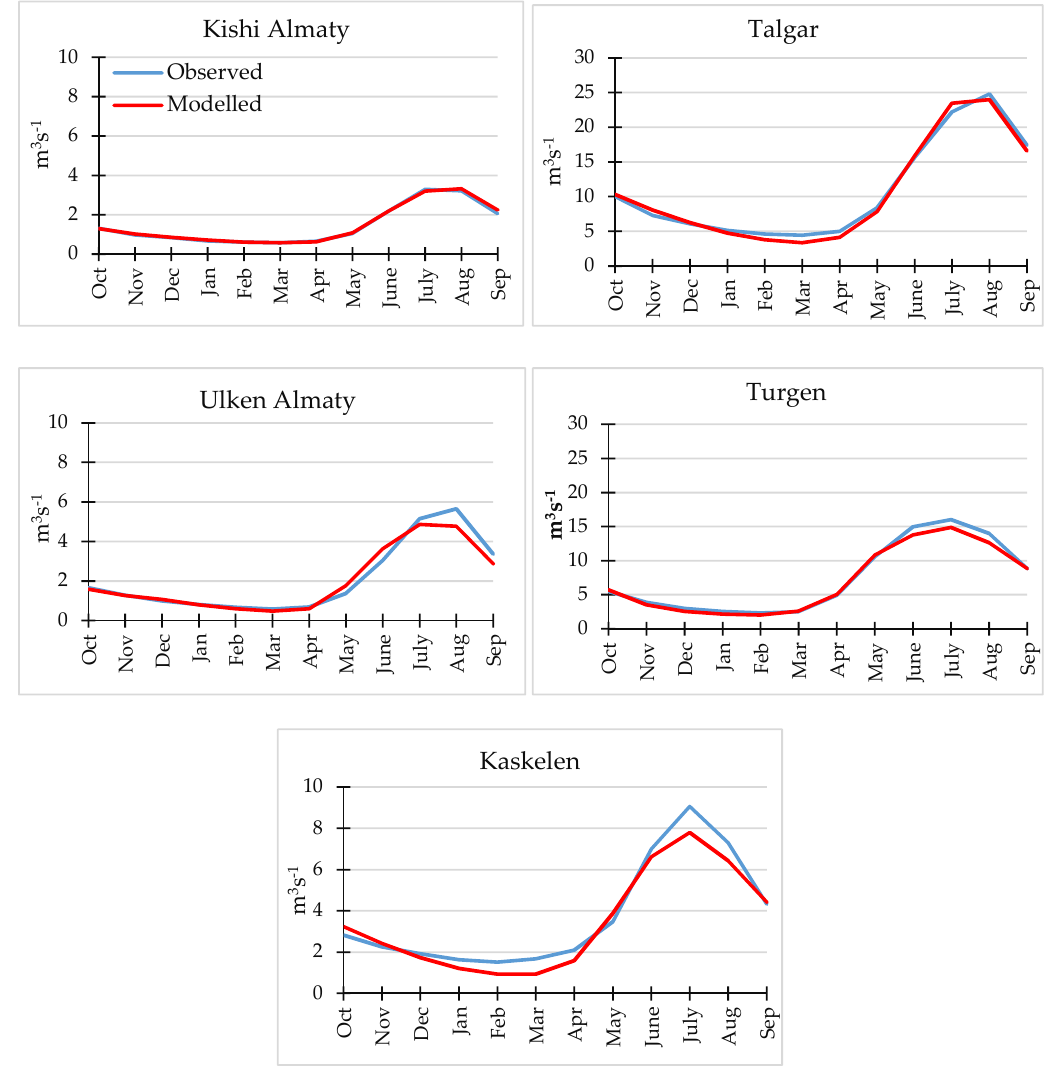
Figure 9. Example of the observed and simulated hydrographs using temperature and precipitation data from the Tuyuksu station for the validation years. Note that different scales are used for (i) Kishi Almaty, Ulken Almaty, Kaskelen and (ii) Talgar, Turgen.